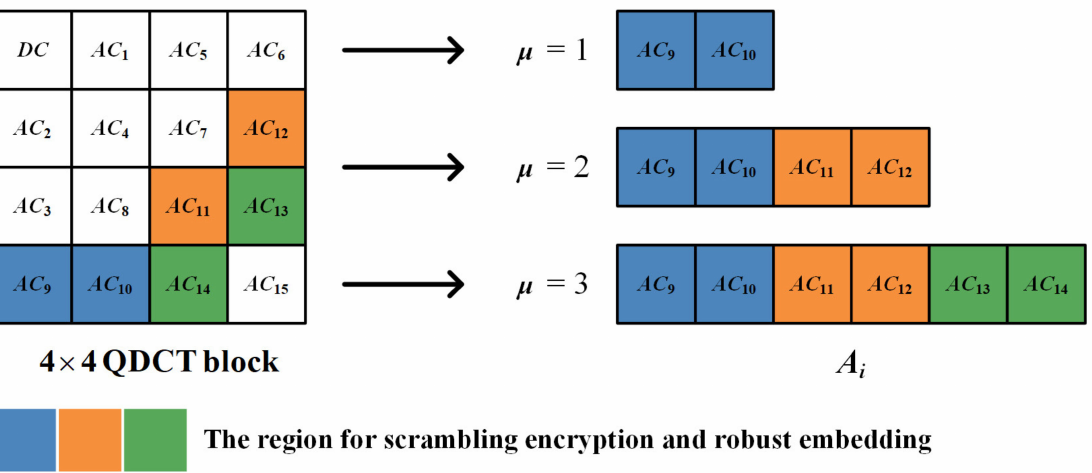
Figure 3. A set of AC